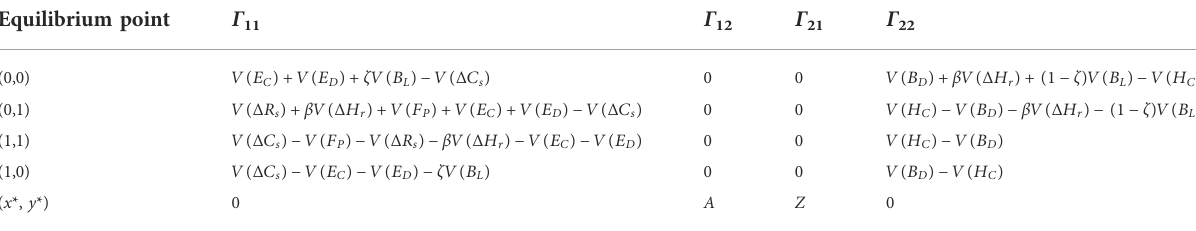
TABLE 2 Speci fi c values of local equilibrium points at Γ 11 , Γ 22 , Γ 12 , Γ 21 . Equilibrium